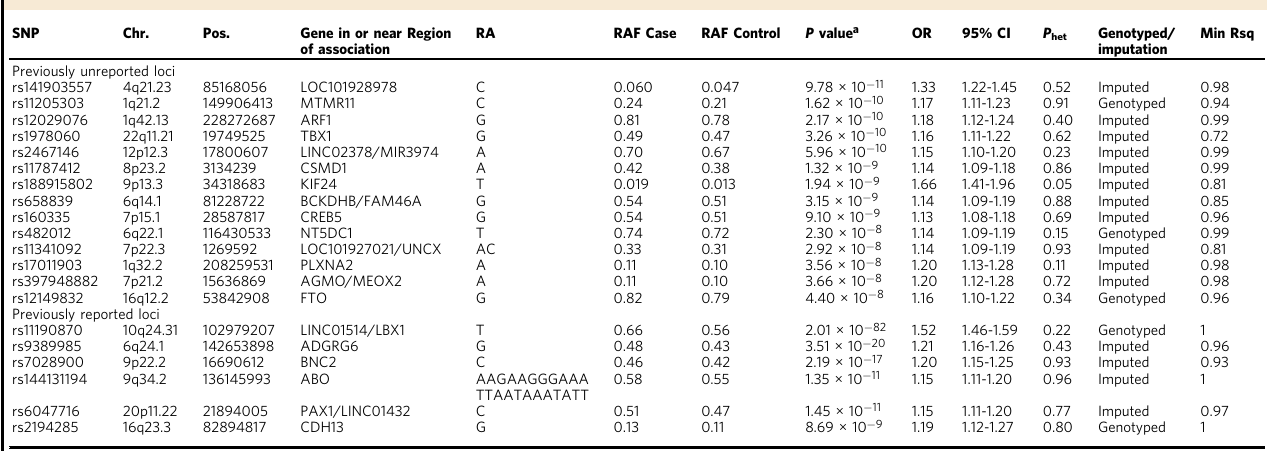
Table 1 Association of the genome-wide signi fi cant loci SNP